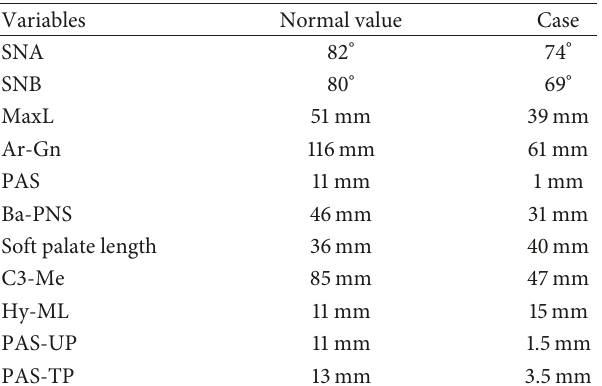
Figure 4: Intraoral features of Table 1: Cephalometric findings.